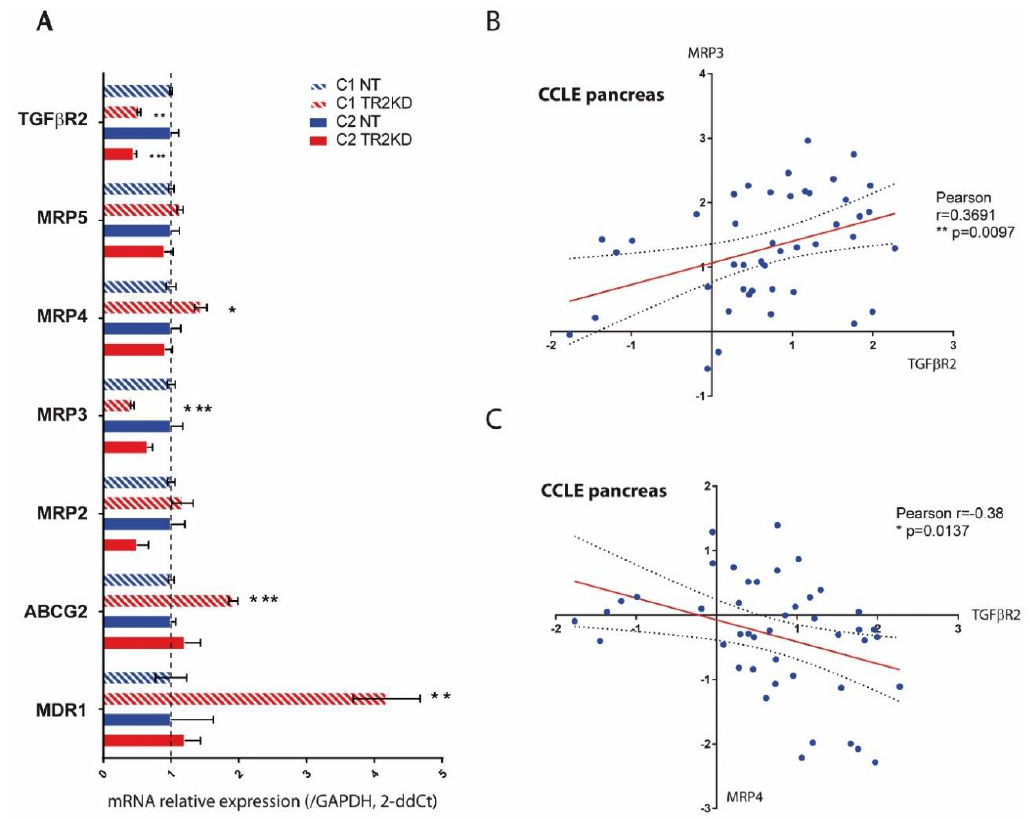
Figure 6. TGF- βRII silencing alters ABC transpo rter expression. ( A ) mRNA expression of TGF- βRII , Figure 6. TGF- β RII silencing alters ABC transporter expression. ( A ) mRNA expression of TGF- β RII , MRP1 , MRP2 , MRP3 , MRP4 , MRP5 , ABCG2 and MDR1 was analyzed in NT and TGF- β